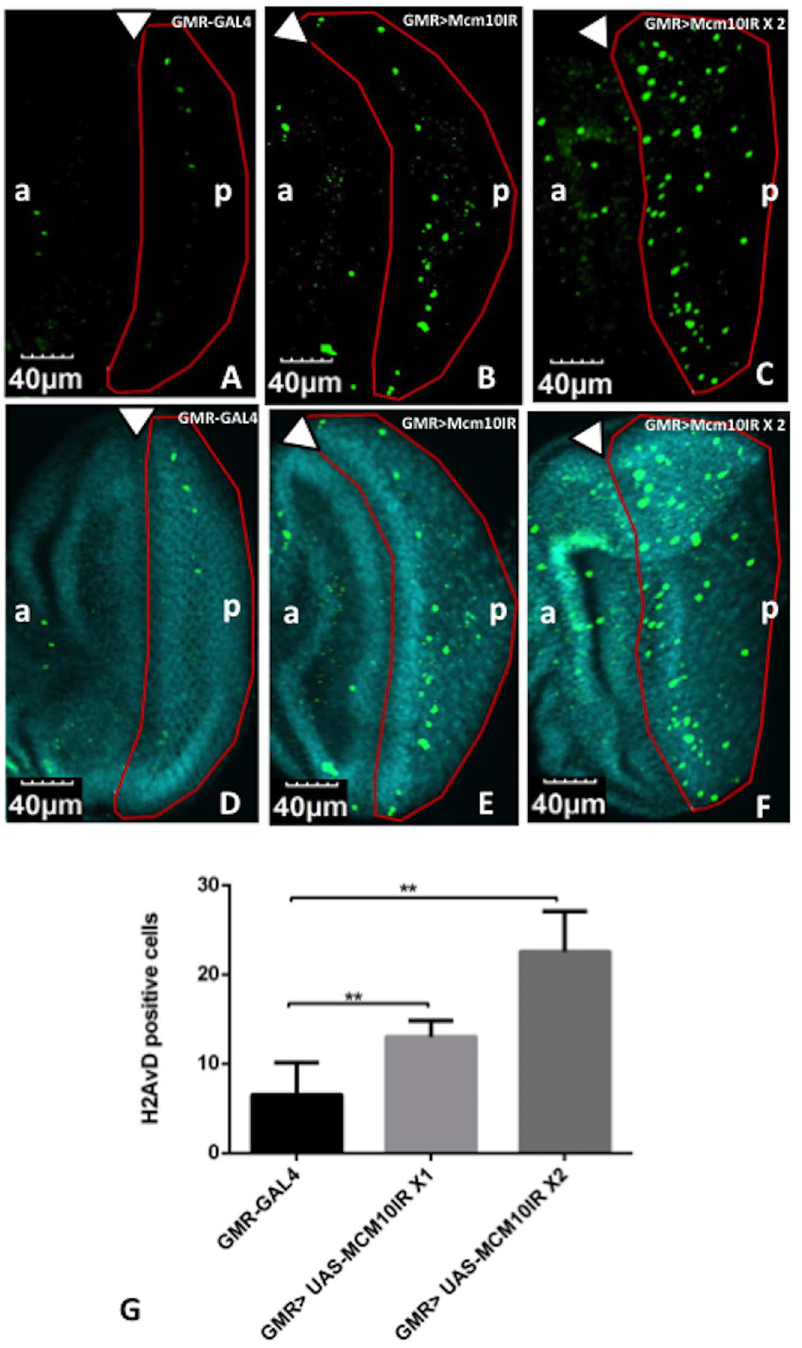
Figure 6. Knockdown of dMcm10 in eye imaginal discs induces DNA damage. The eye imaginal discs were stained with anti-phospho H2AvD antibody (Green) (A, B, C). Also shown are merged images of the eye discs stained with DAPI for DNA (Blue) and anti-phospho H2AvD antibody (Green) (D, E, F). (A, D) GMR -GAL4/ yw ; + ; + ; (B, E) GMR -GAL4/ yw ; + ; UAS- Mcm10IR 633-700 / + ; (C, F) GMR -GAL4/ yw ; + ; UAS- Mcm10IR 633-700 /UAS- Mcm10IR 633-700 . The white arrowhead shows the morphogenetic furrow. The flies were reared at 28 u C. Bars indicate 40 m m. (G) Quantification of phospho-H2AvD positive index in the posterior region of eye discs. There was an increase in the phospho-H2AvD positive signals with two copies of dMcm10 dsRNA in the posterior region compared to control, GMR -GAL4 alone. One copy of the dsRNA also caused an increase in DNA damage signal, but not as much as for two copies. **p , 0.01. The red border line indicates the posterior region. (a) indicates anterior, (p) indicates posterior. doi:10.1371/journal.pone.0093450.g006 decreased levels of dMcm10 signals (Red) (Figure 3B and D) S-phase zone behind the morphogenetic furrow (Figure 3A). In the flip-out experiments, cells marked with GFP (Green) expressed confirming the specific knockdown of dMcm10 in the eye disc by dMcm10 dsRNA (Figure 3C). The GFP marked cells showed expression of dMcm10 dsRNA.